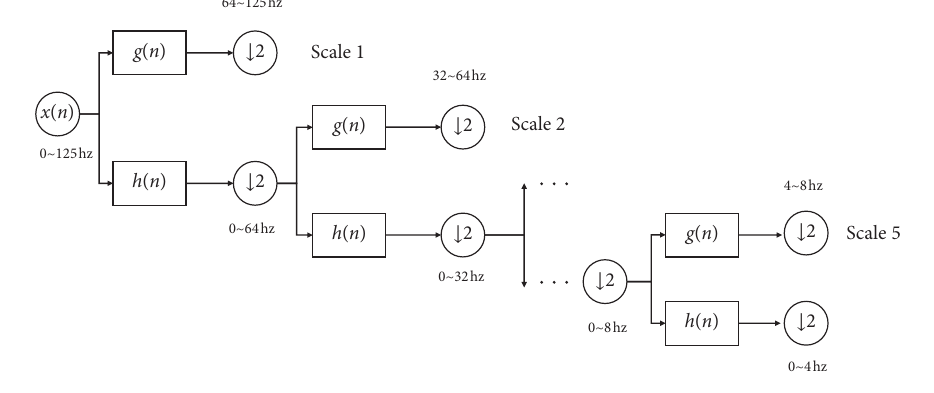
Figure 2: Schematic diagram of wavelet